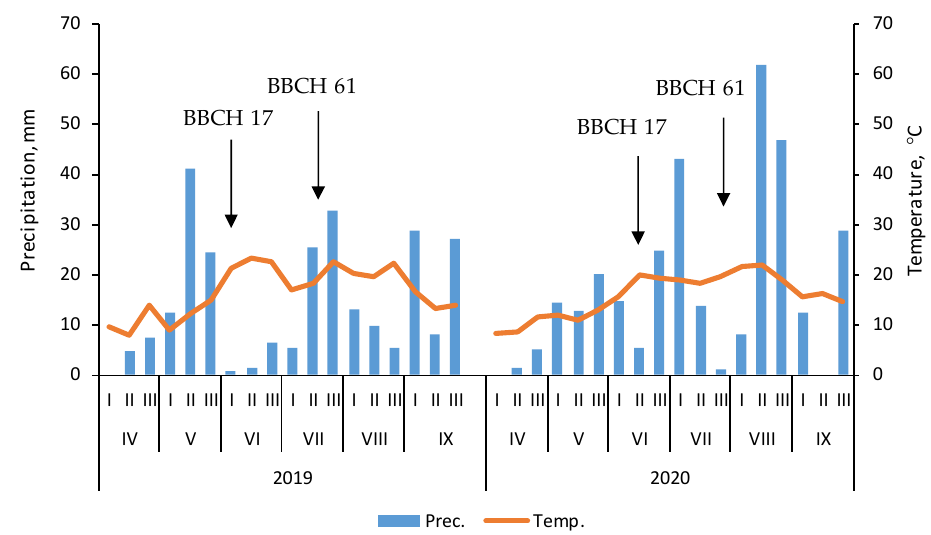
Figure 5. Air temperature and precipitation during 2019–2020 growing seasons of maize (in decades of the month). Key growth stages: BBCH 17—seventh leaf growth stage; BBCH 61—onset of flowering. Source: Poznan University of Life Sciences Experimental Station in Brody.